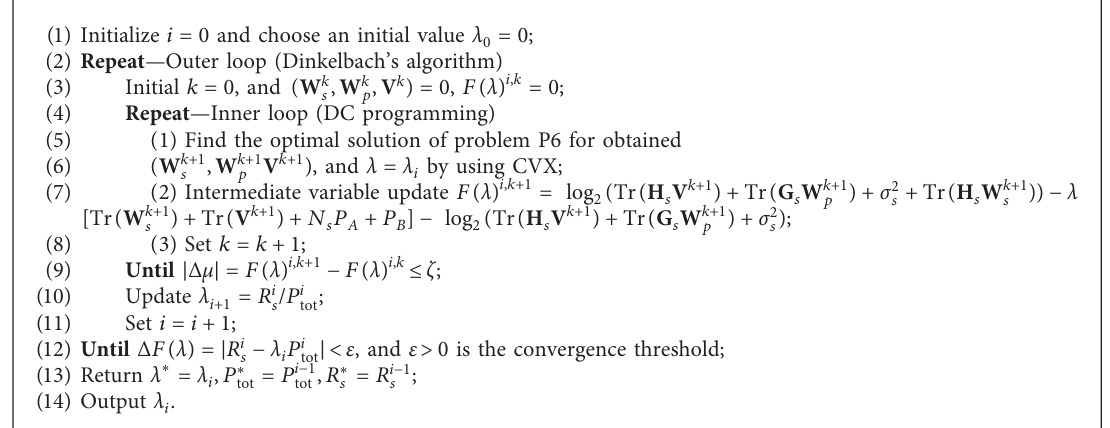
A LGORITHM 1: The proposed EEM algorithm to solve P